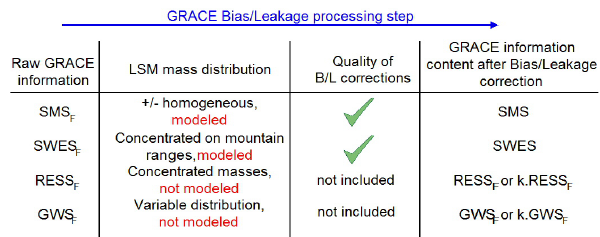
Fig. 1. Schematic showing the impact of modeled and unmodeled storage compartments in LSMs on the Bias/Leakage correction, considering a perfect LSM limited to SMS and SWES. Subscript F represents spatial filtering, i.e., truncation to degree 50 (equivalent to GRGS processing) and degree 60 (equivalent to CSR processing), and 300km Gaussian filtering (CSR). Two bias/leakage correction methods may be used: a multiplicative method, applying a factor k based on mass distribution from LSM, or an additive hypothesis. In both cases, as storage compartments do not have the same mass dis- tribution, bias/leakage corrections are only valid for modeled stor- age compartments in LSMs, which generally do not include RESS and GWS. Rescaled GRACE data may correctly describe SMS and SWES, other components, however, are not properly